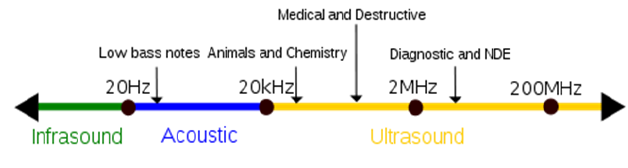
Figure 4. Sound frequency